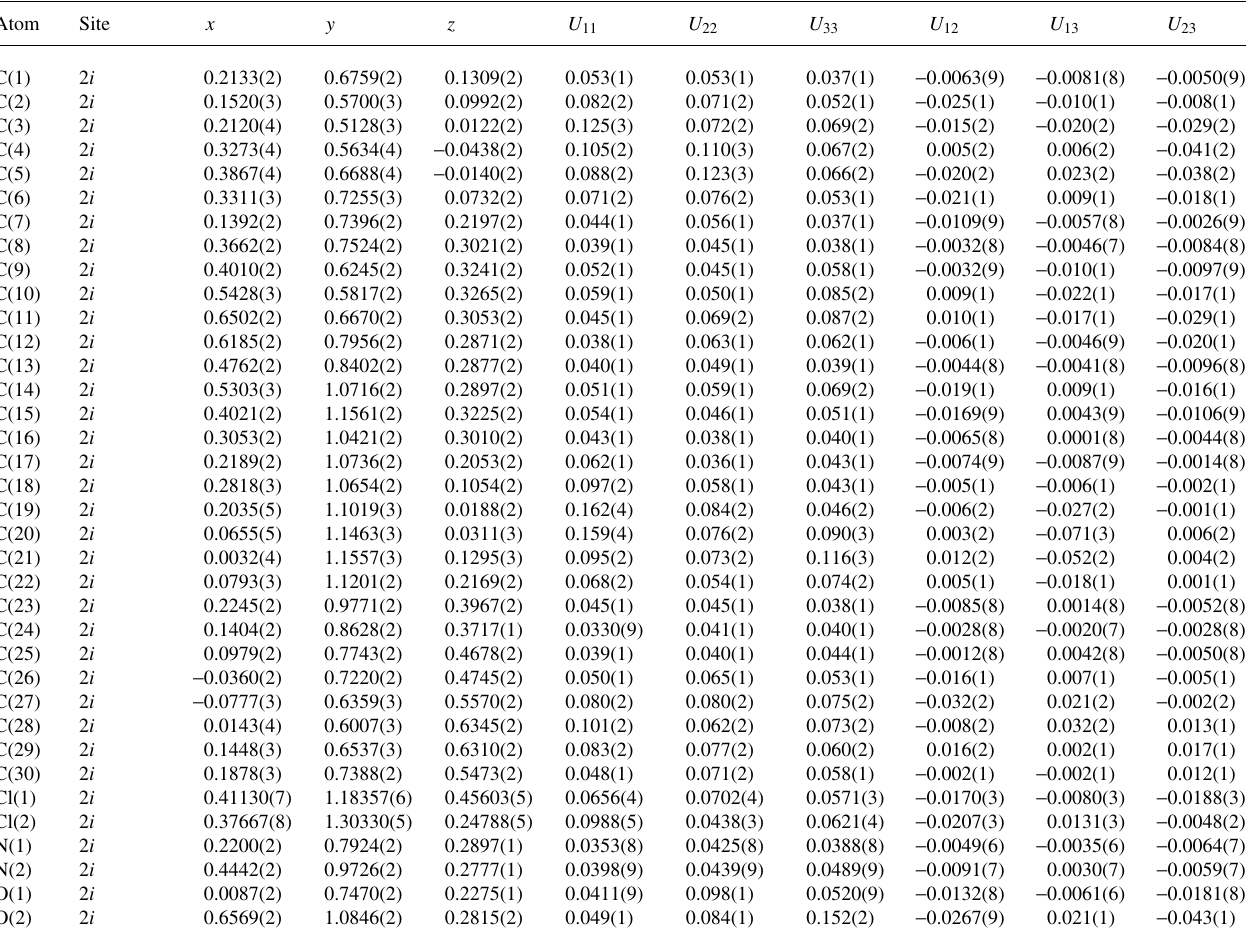
Table 3. Atomic coordinates and displacement parameters (in Å 2 )